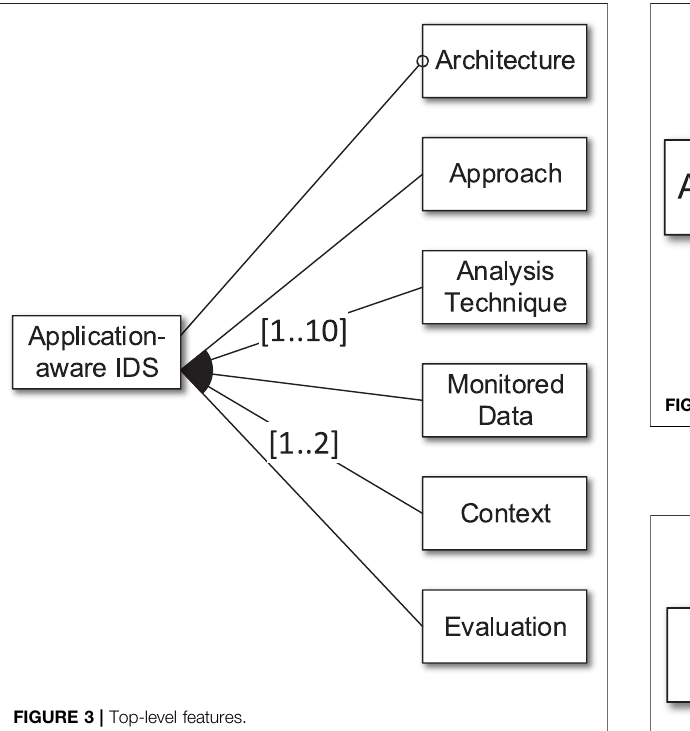
FIGURE 3 | Top-level features.